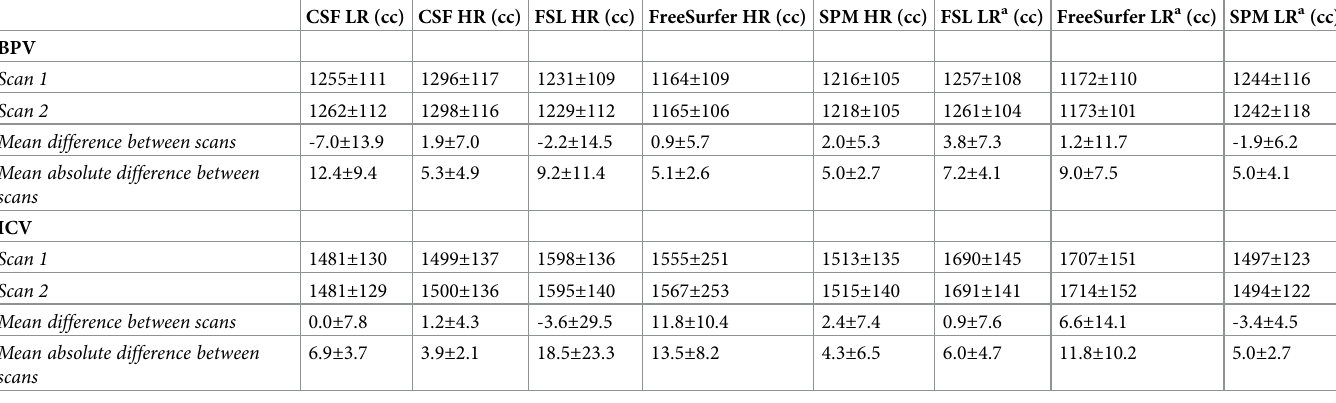
Table 1. Precision of BPV and ICV for CSF LR, CSF HR and automated segmentation methods with downsampled data.